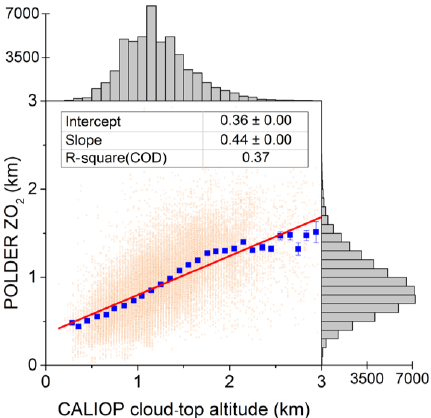
Figure 3. POLDER cloud altitude (ZO 2 ) compared to CALIOP cloud-top altitude, over a period of 6 months (May to October) from 2006 to 2010 along the CALIOP track. Lateral histograms show the data